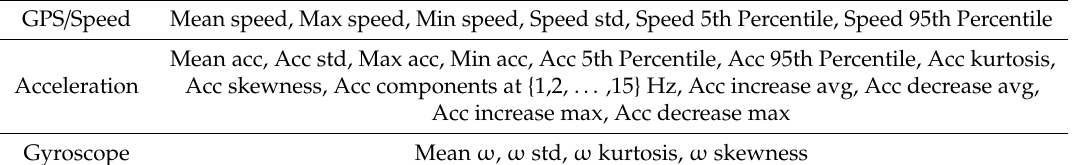
Table 3. The statistical features extracted in the pre-processing.